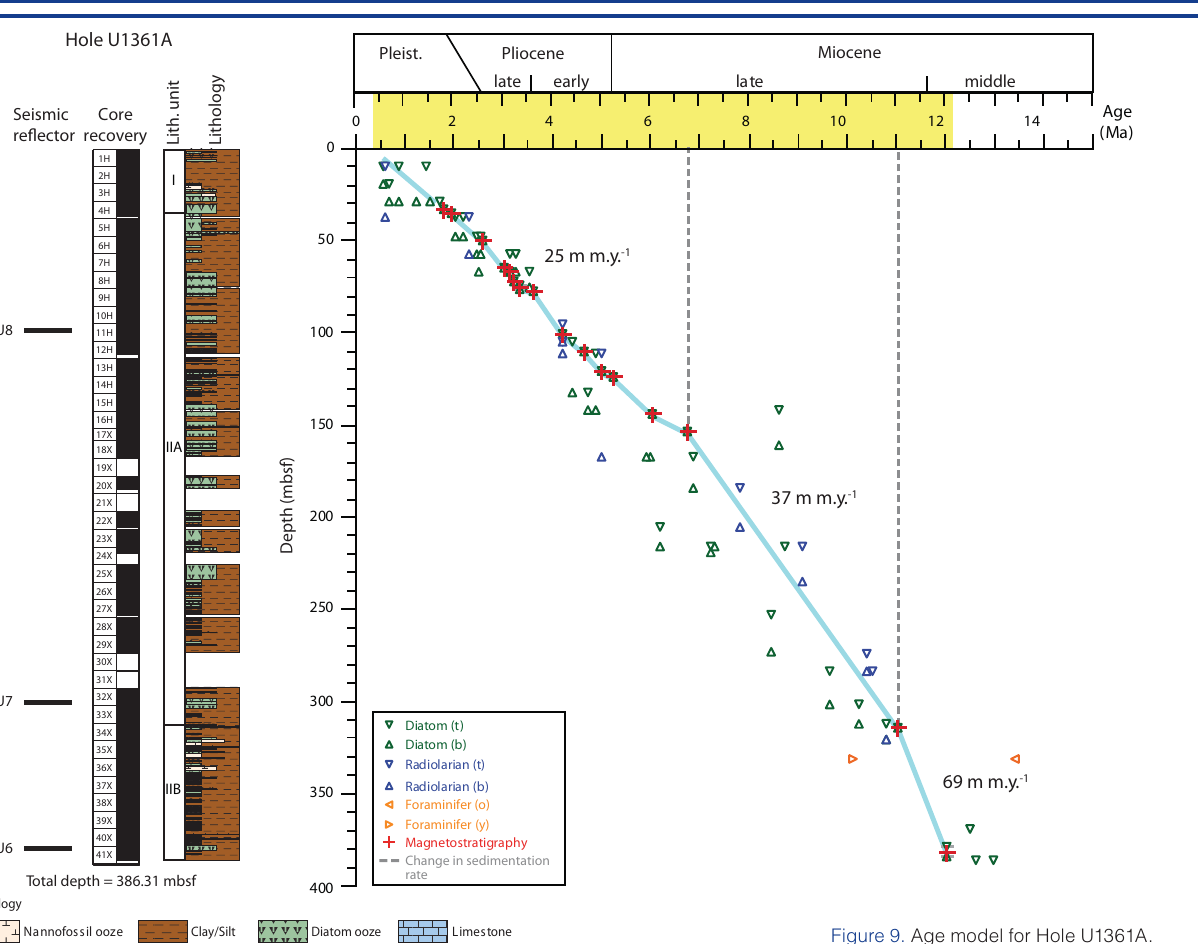
Figure 9. Age model for Hole U1361A.